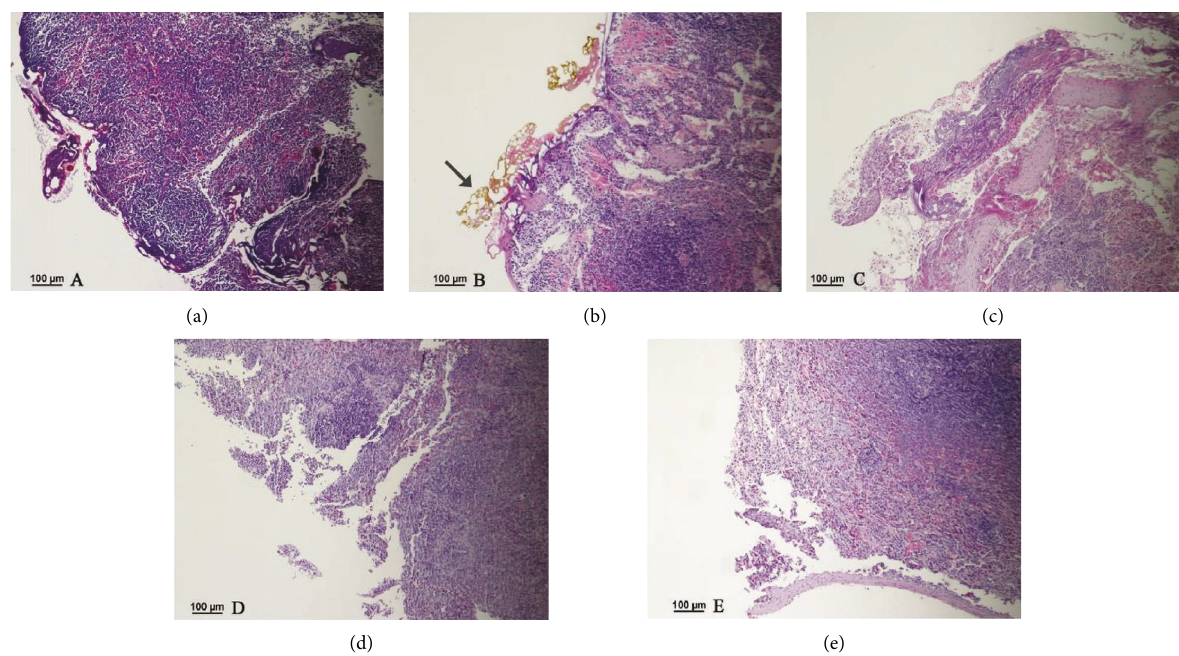
Figure 3: Differences in wound edges following the use of various cutting methods. (a).Uneven wound edge of cut made with an electrocoagulator. (b).Smooth straight wound edge of cut made with a laser, yellow to black pigment accumulation (carbonization) near the wound edge (arrow). (c).Uneven wound edge of cut made with a tissue-welding device. (d).Uneven, torn wound edge of cut made with the radiofrequency device. (e).Smooth, slightly uneven wound edge of cut made with a scalpel.